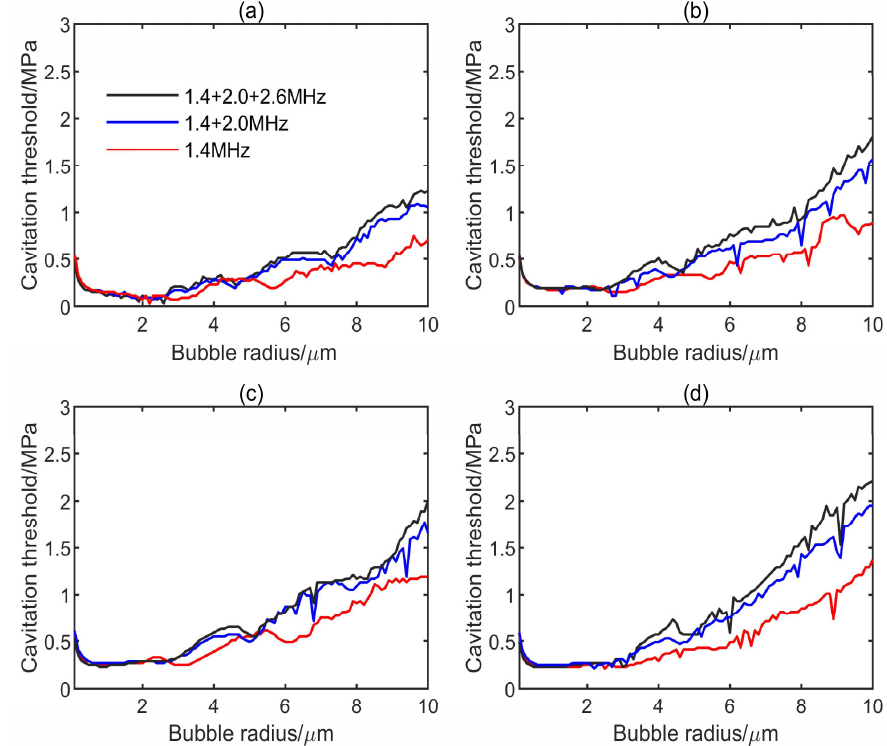
Figure 3. Transient cavitation threshold of single-frequency (1.4 MHz), dual-frequency (1.4 + 2.0 MHz), and triple-frequency (1.4 + 2.0 + 2.6 MHz) in different media: ( a ) water; ( b ) blood; ( c ) brain; ( d ) liver.